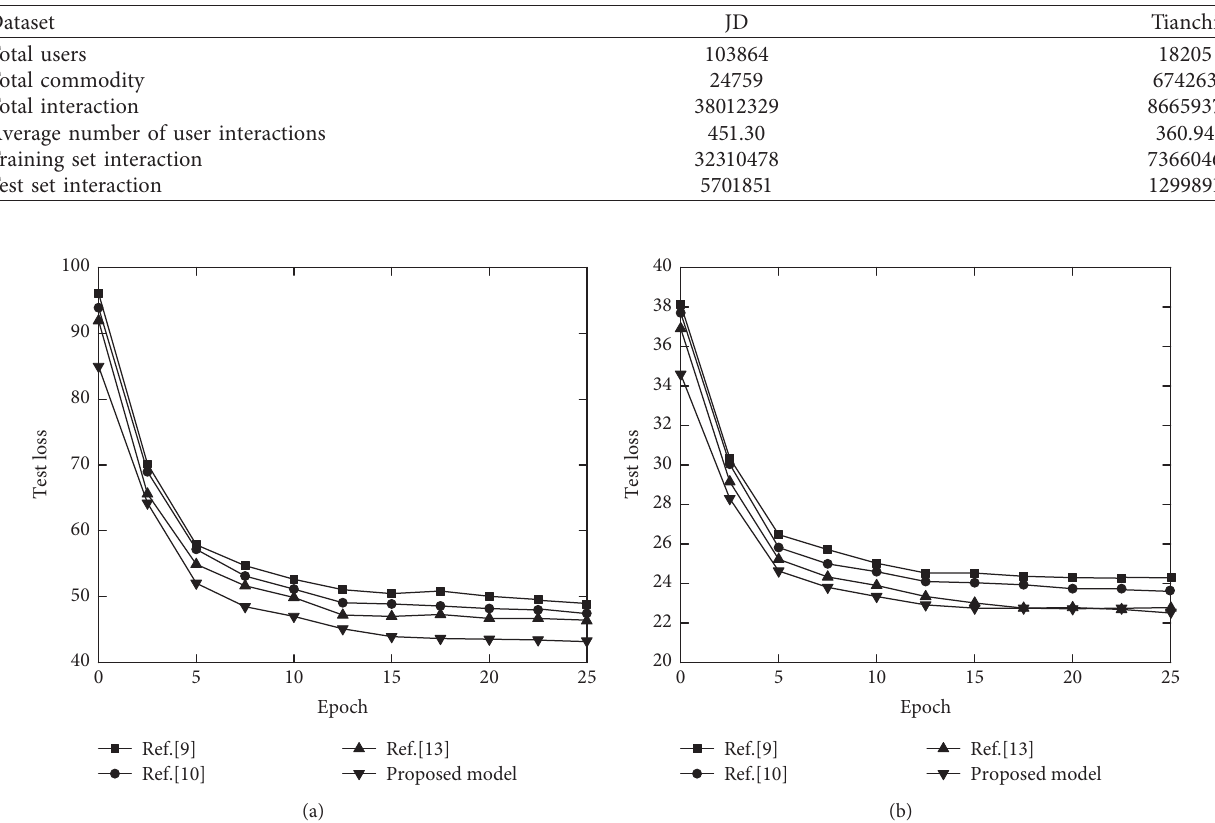
Table 2: Preprocessed dataset parameters.